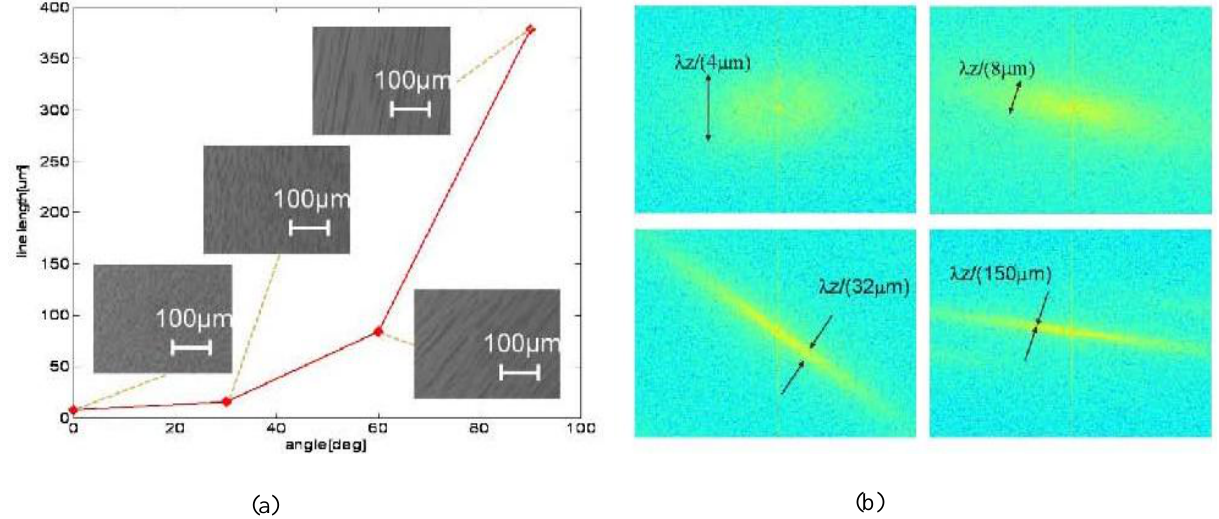
Figure 8. Superparamagnetic particle angle dependent. (a) Plot of the aligned line array as a function of the magnet angle; (b) Spectrum of the aligned lines corresponding to the angle of the